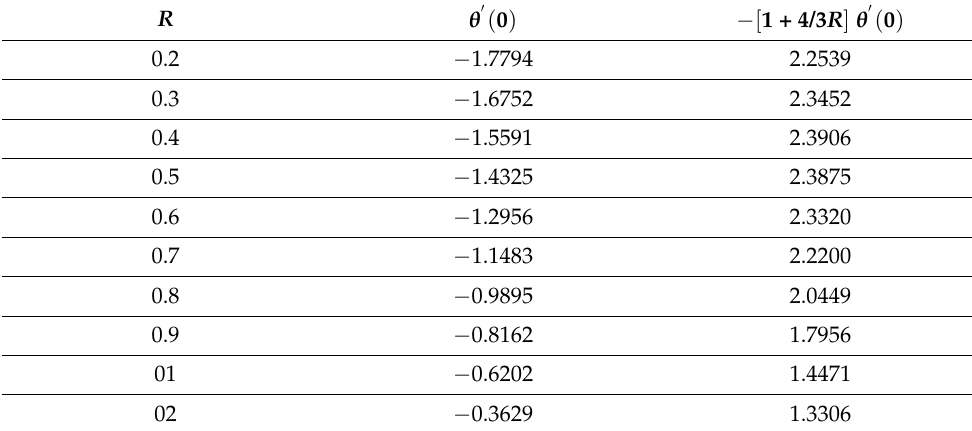
Table 8. Impact of radiation parameter on Nusselt number.